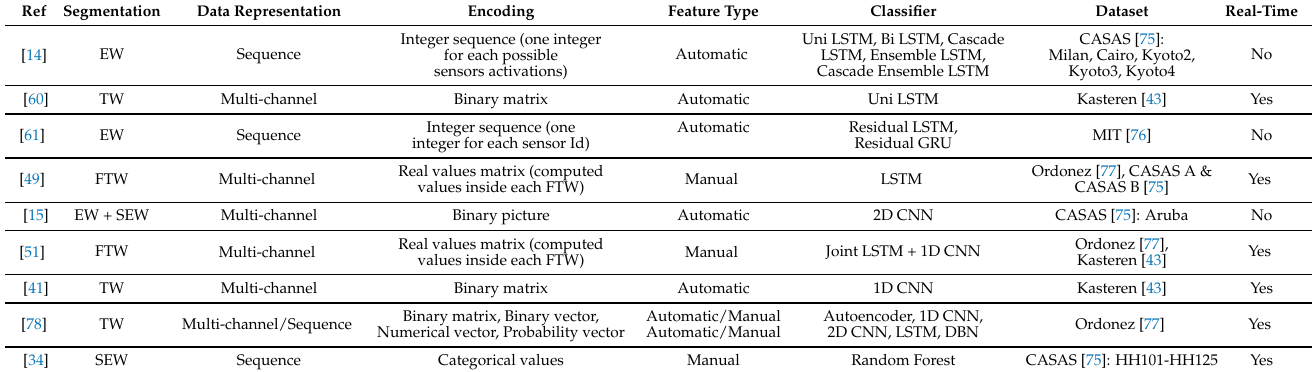
Table 2. Summary and comparison of activity recognition methods in smart